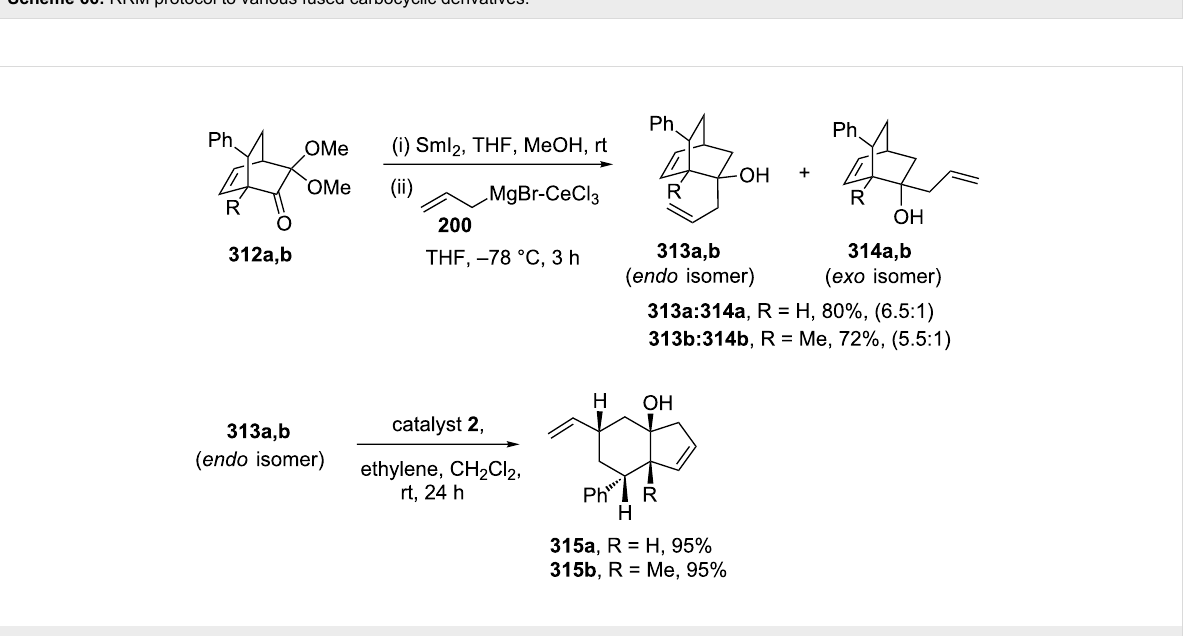
Scheme 67: RRM to cis -hydrindenol